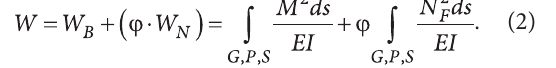
table 4. Energy of the elements of each bridge under dead loads Energy W